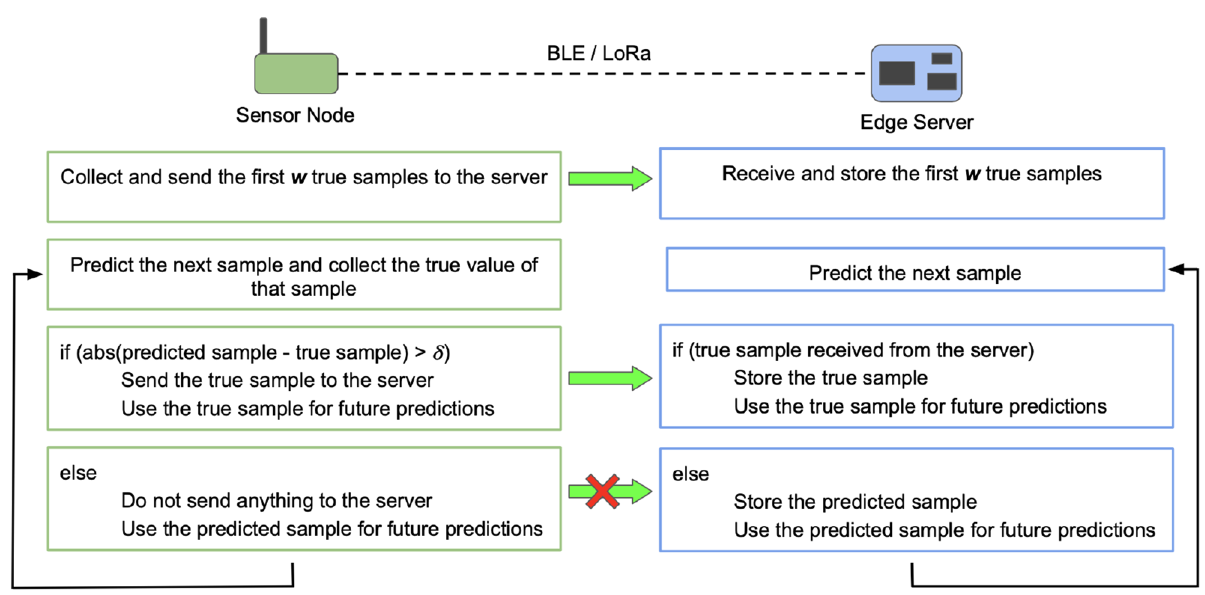
Figure 2. Proposed protocol—Ambrosia: w is the window size and δ is the error